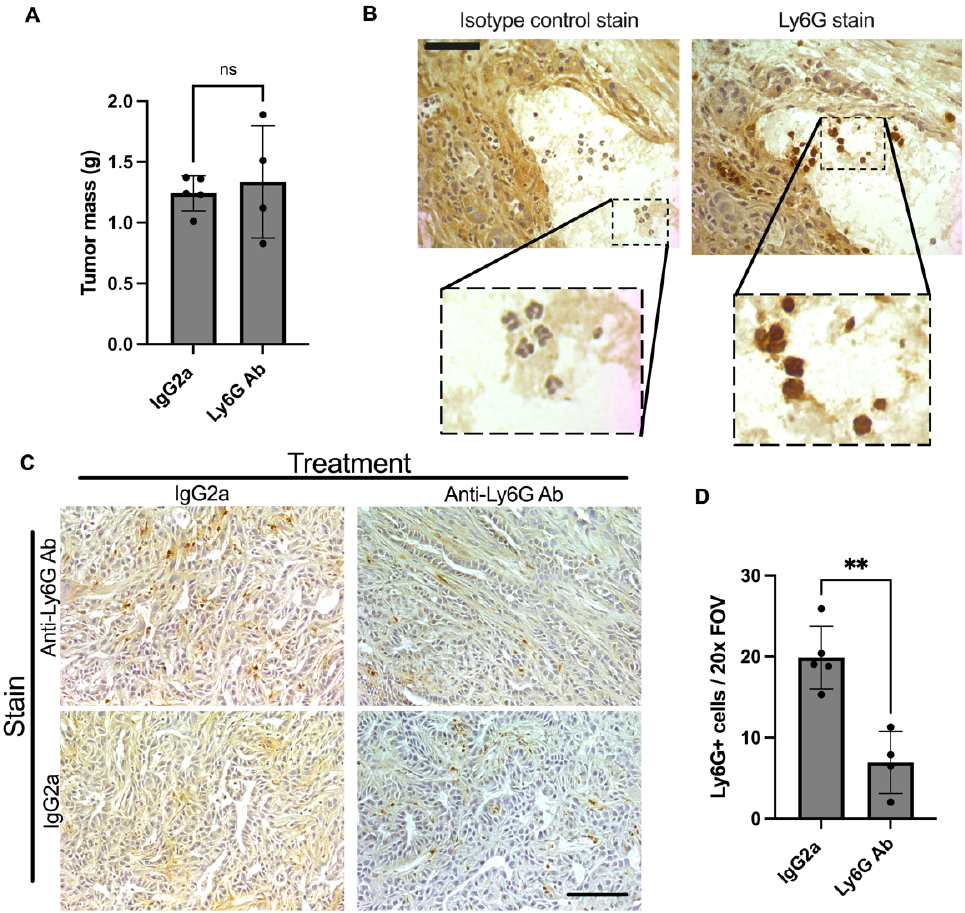
Figure 3. Effect of Ly6G antibody treatment on tumor. Orthotopic KPC tumor-bearing mice were treated with an anti-Ly6G antibody (1A8) or isotype control (2A3) every 3 days starting at 5 days post inoculation. ( A ) Endpoint tumor mass was not different between groups (ns = not significant). ( B ) Serial sections were also stained using the isotype control antibody (2A3) in parallel. This shows a high magnification (40 × ) view of serial sections. Comparing the stains shows that cells with characteristic multilobed nuclei pick up the Ly6G stain. Scale bar = 50 µ m. ( C ) Representative tumor sections stained with anti-Ly6G antibody (1A8) to detect Ly6G+ cells in the tumor. While KPC tumors from isotype control-treated mice did not show positive immunoreactivity in the absence of the Ly6G antibody, KPC tumors from mice treated with anti-Ly6G treatment showed some cells with positive immunoreactivity. These cells likely reflect Ly6G+ cells labeled, but not yet depleted, by the 1A8 antibody in vivo (during treatment). Images were taken at 20 × magnification. Scale bar = 100 µ m. ( D ) KPC tumors from isotype control-treated mice ( n = 5) had significantly more Ly6G positive cells per field of view (FOV) than those from anti-Ly6G antibody-treated mice (** p < 0.001; n = 4). KPC tumor-bearing mice also showed a significant increase in the number of Ly6G+ cells in the TA muscle, an effect that was significantly attenuated by anti-Ly6G treatment The area of Ly6G+ staining in the diaphragm was likewise significantly greater in tumor- bearing animals; however, the attenuation by anti-Ly6G treatment did not reach